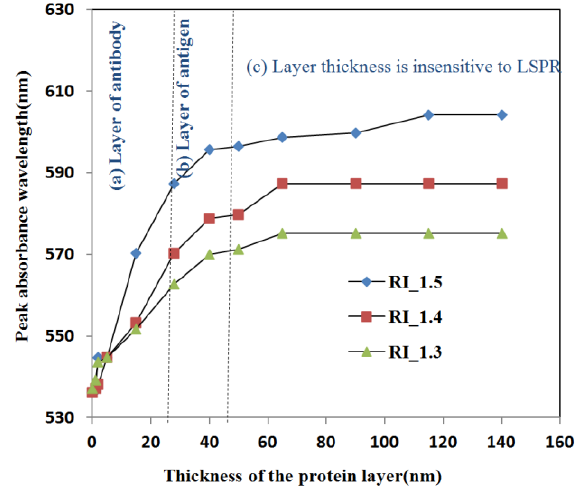
Figure 7. Variation of LSPR peak against the thickness of the